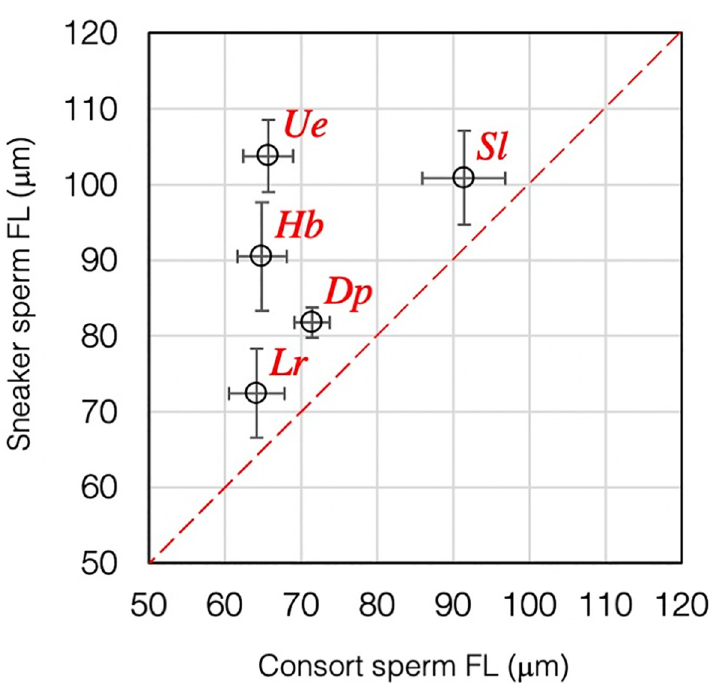
Fig 2. Comparison of sperm flagellum length between consorts and sneakers in five coleoid squids exhibiting Alternative Reproductive Tactics (ARTs). Intraspecific sperm dimorphism between sneakers and consorts in five species of loliginid squids. Each data point represents the mean ± SD with 8–52 male individuals (see Materials and Methods ). Hb, H . bleekeri ; Dp, D . pleii ; Ue, U . edulis ; Sl, S . lessoniana ; and Lr, L . reynaudii .